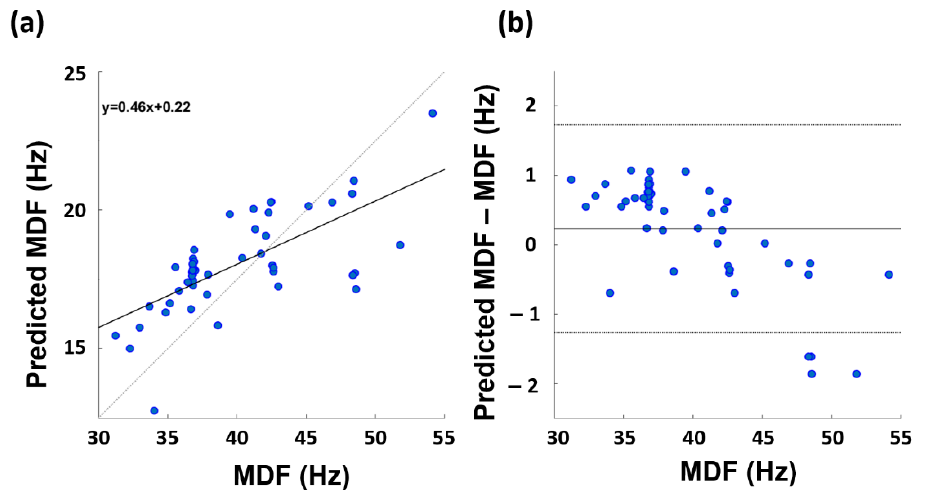
Figure 5. Correlation plot ( a ) and the Bland – Altman plot ( b ) associated to the performance of the Gaussian model developed to estimate the MDF.